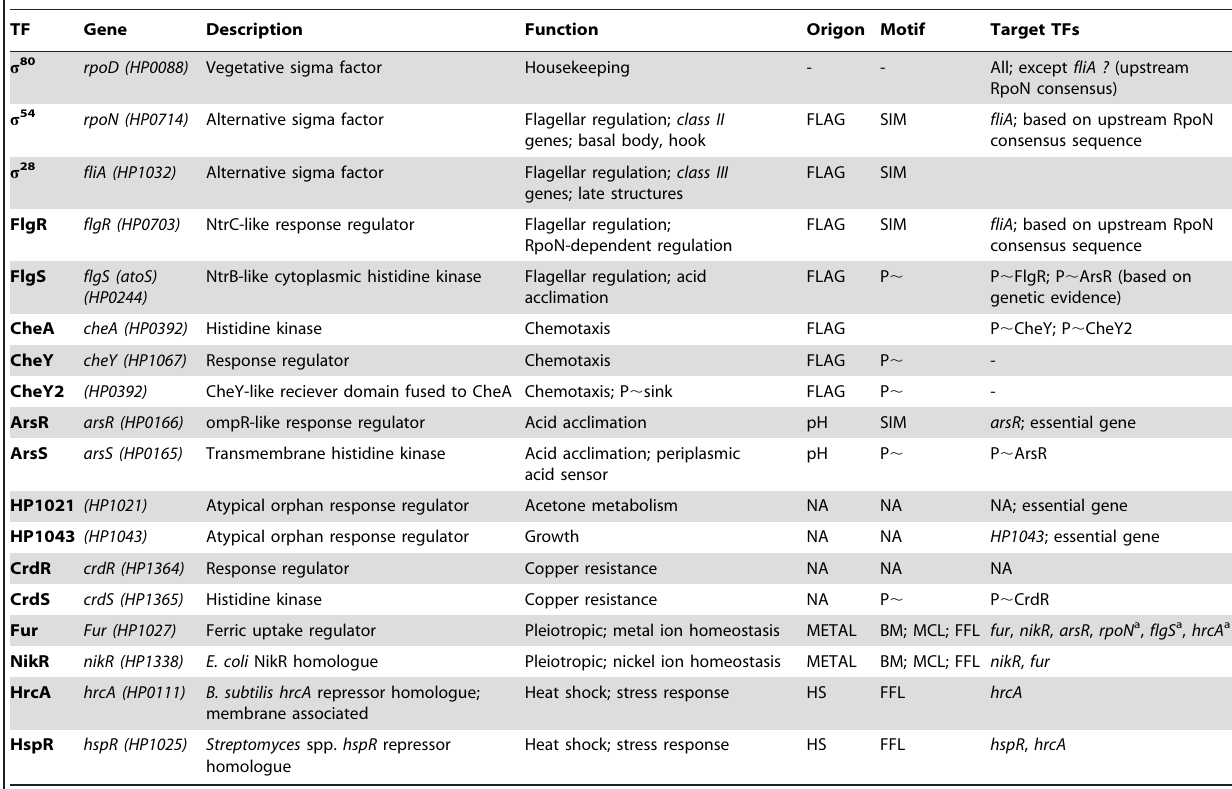
Table 1. H. pylori transcription factors and